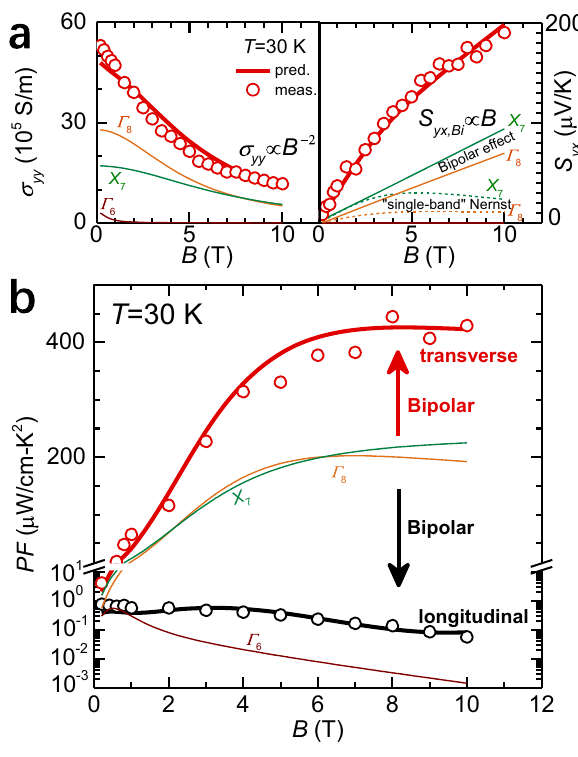
Fig. 6 Field-dependent transport properties for Mg 2.33 Pb at 30 K. a Longitudinal conductivity ( σ yy ) and transverse thermopower ( S yx ). b Longitudinal ( S xx 2 σ xx , red line) and transverse ( S yx 2 σ yy , black line) power factor. The partial contributions of Γ 6 and Γ 8 valence bands and X 7 conduction band are estimated based on a three-band model.